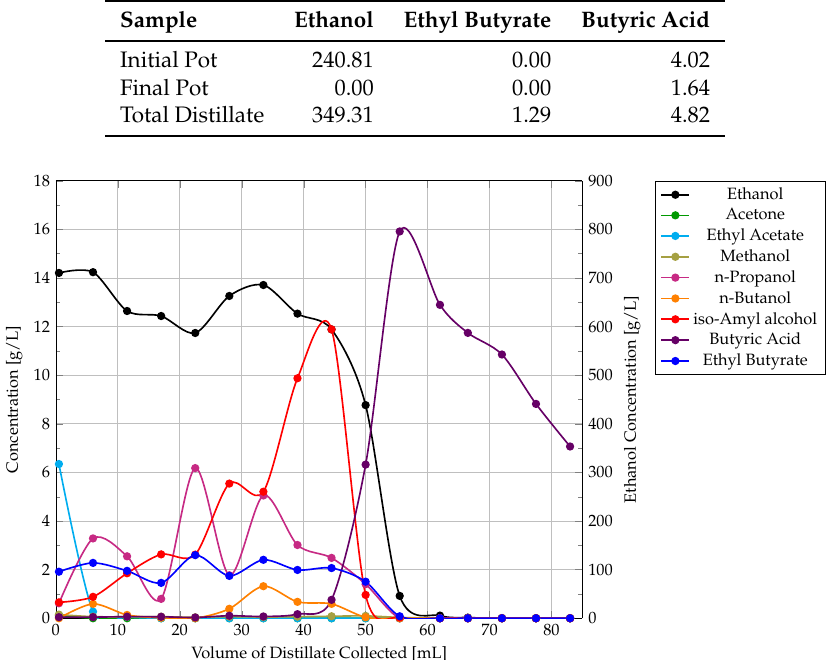
Table 1. Compounds of interest in the reactive distillation system. Concentrations in [g/L].